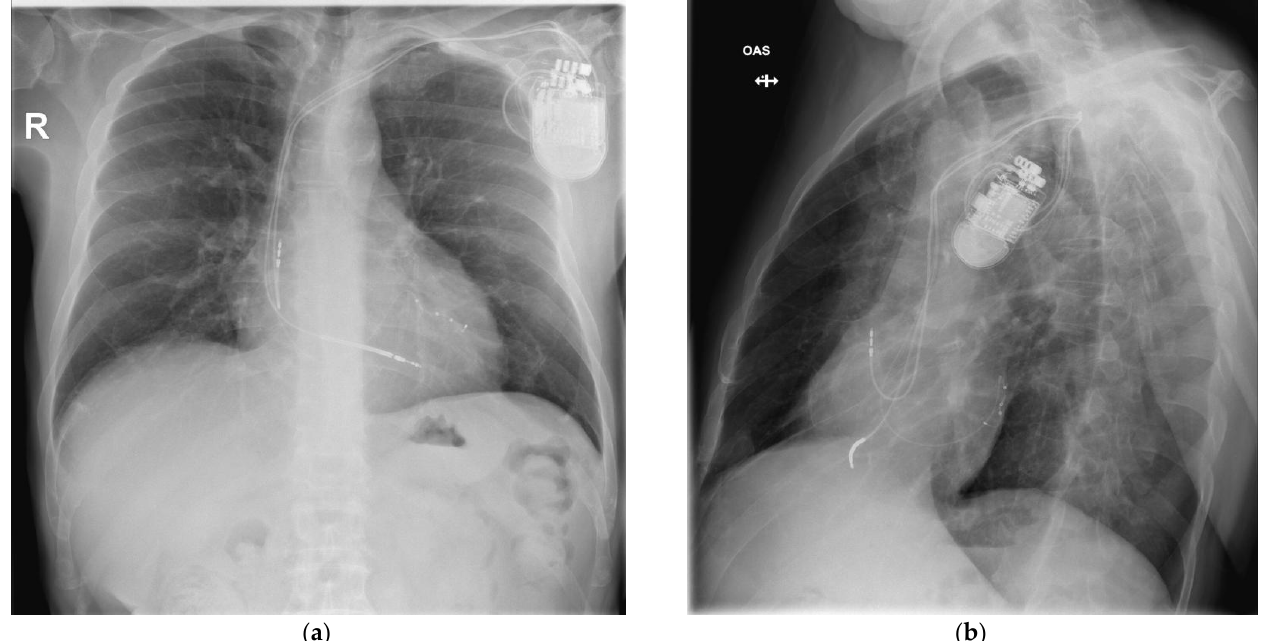
Figure 7. CRT-D system with leads in normal positions: ( a ) posteroanterior view and ( b ) left anterior oblique view.